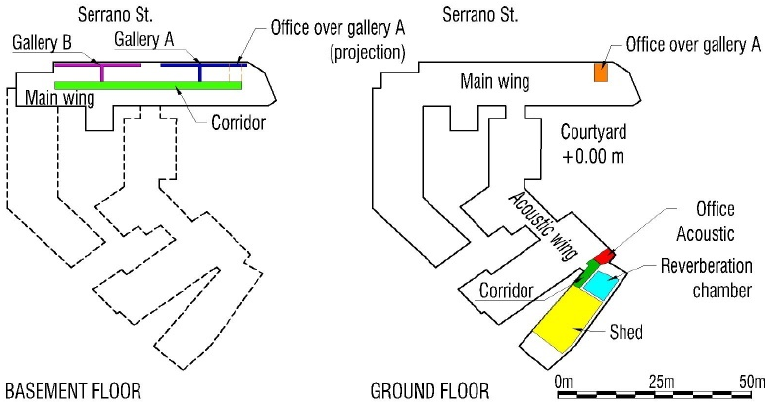
Figure 1. Placement of the studied spaces in the building. The courtyard garden level was taken as the reference height (+0.00) for all plans. Table 1. Dimensions and characteristics of the analyzed spaces.